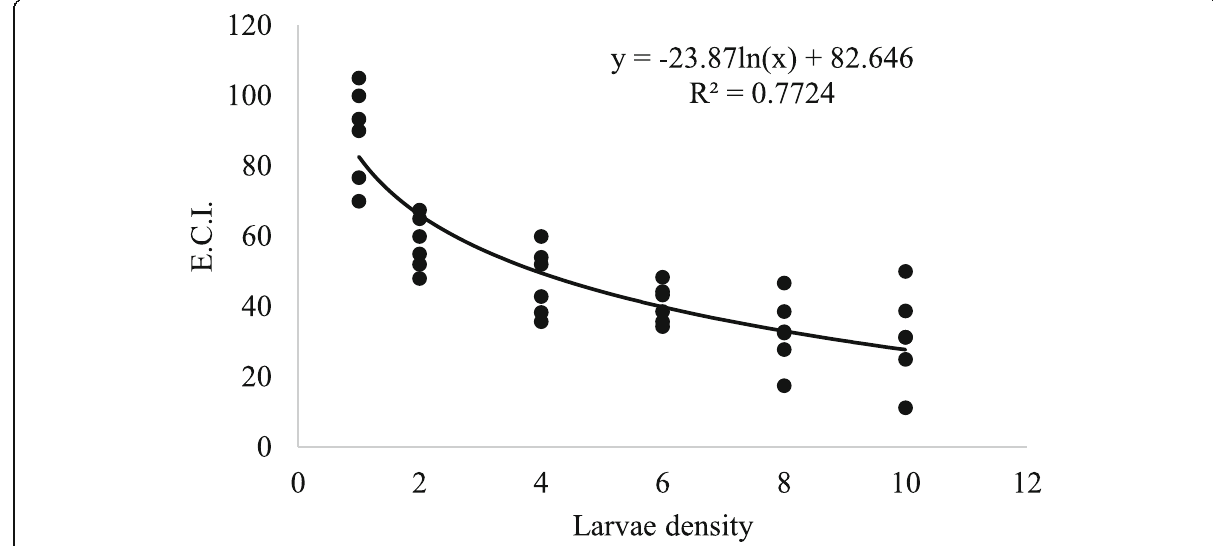
Fig. 5 Relationship between efficiency of ingested feed conversion (ECI) to egg biomass of A. biannulipes at varying densities of P. truncatus larvae